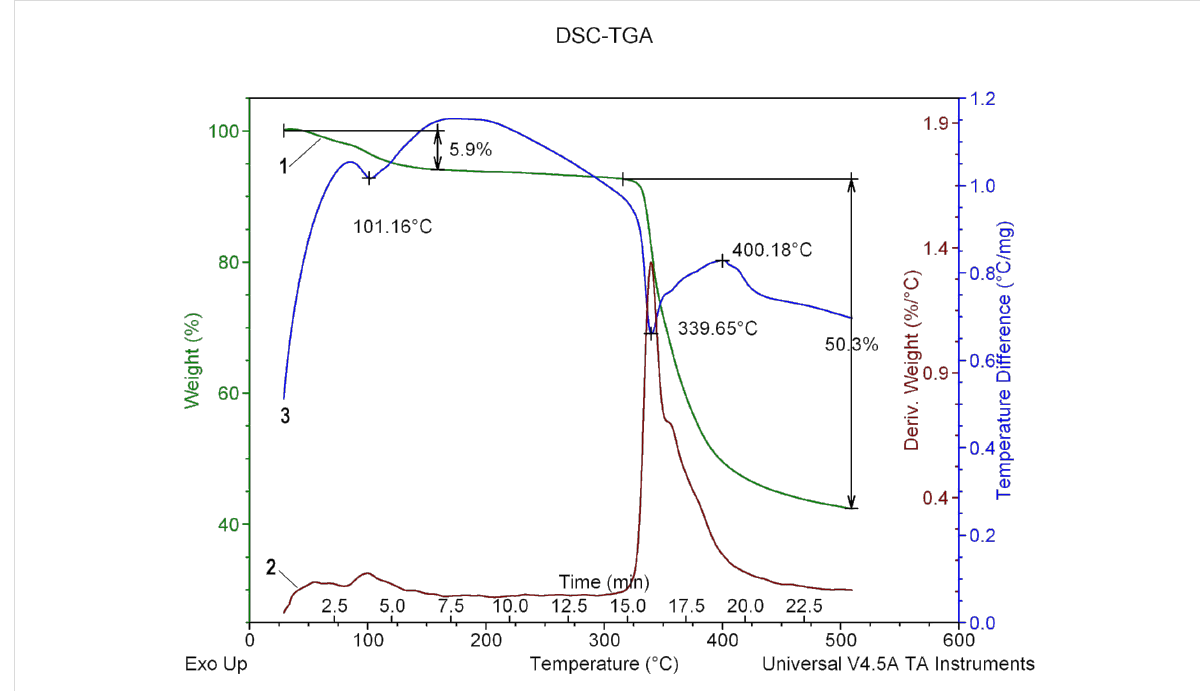
The thermogravimetric analysis and differential scanning calo- rimetry (TGA-DSC) of F-1 was conducted to examine its ther- mal properties. The TGA curve of the bulk crystals (Figure